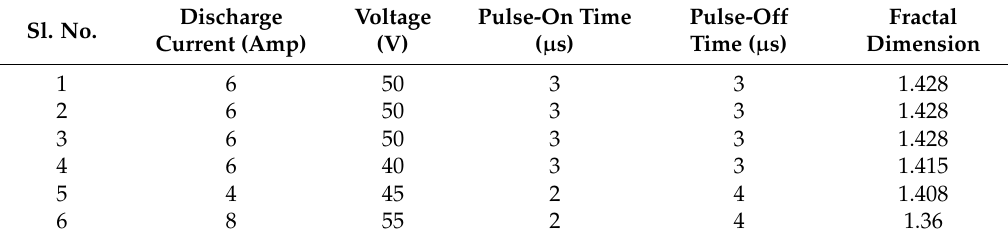
Table 2. Combination of process parameters and experimental